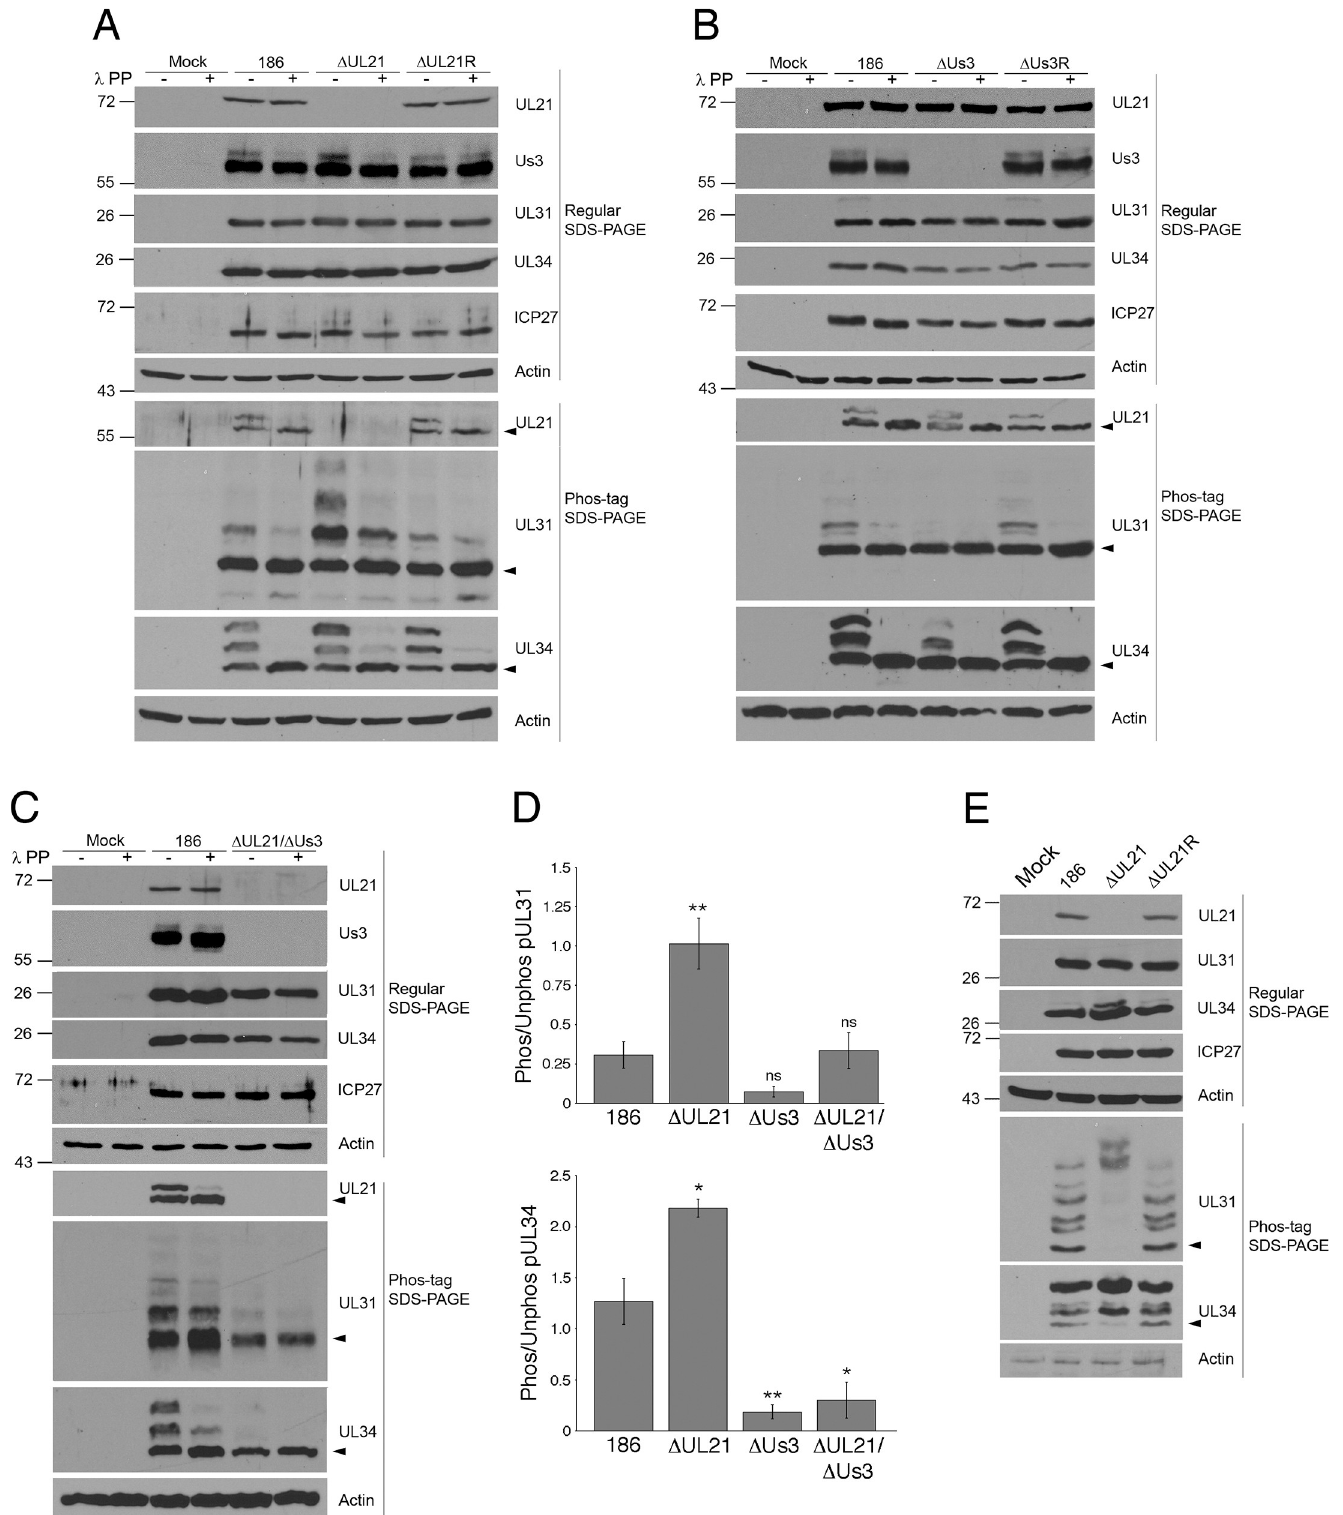
Fig 3. Impact of pUs3 and pUL21 on the phosphorylation of NEC components pUL31 and pUL34. (A, B and C) Whole cell lysates prepared at 18 hours post infection from Vero cells infected at an MOI of 3 with the viruses indicated at the top of the panels or from mock infected cells were either treated with λ